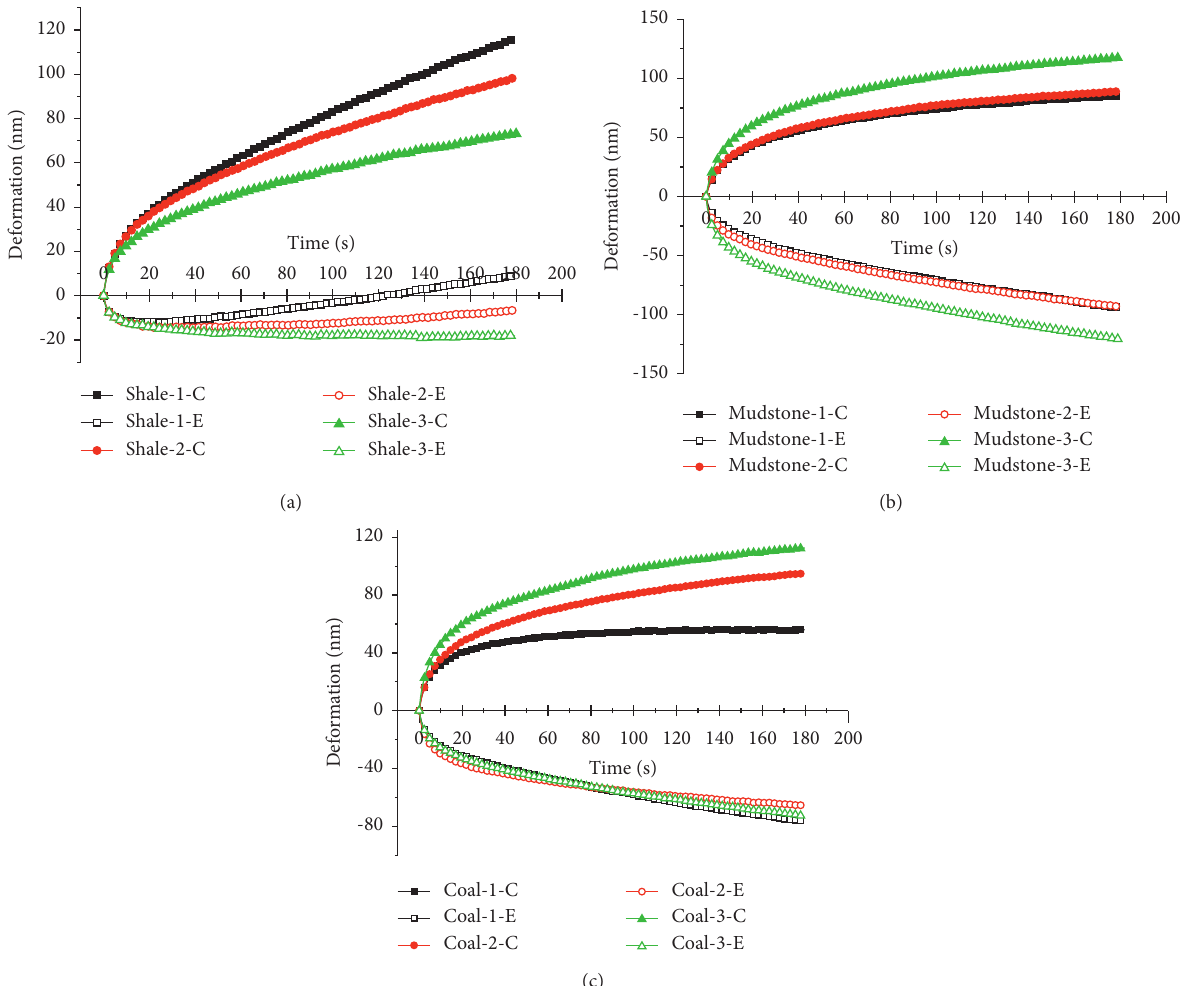
Figure 2: Deformation-time curves of (a) shale, (b) mudstone, and (c) coal during stage b - c (-C) and that during stage d - e (-E) starting from